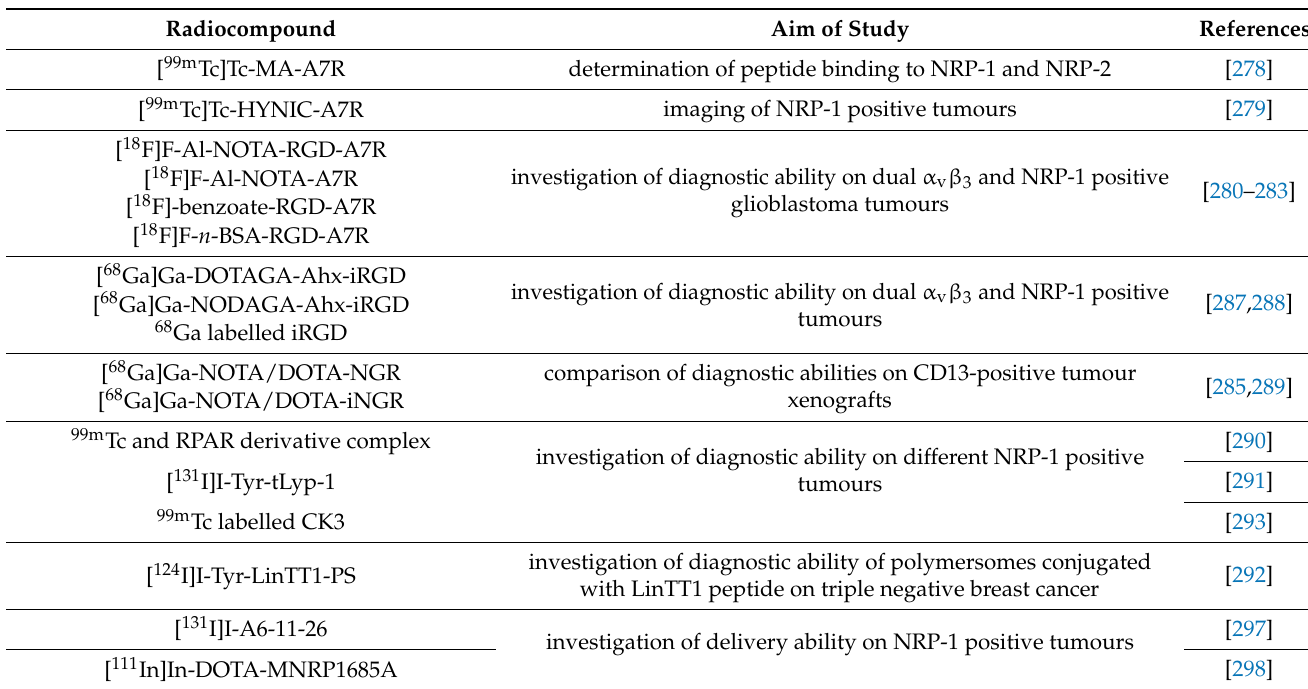
Table 5. NRP-1 targeting